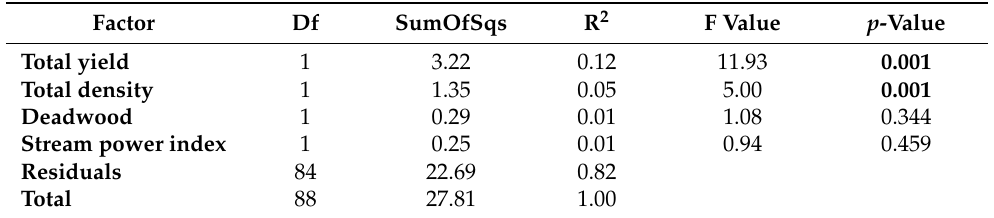
Table 1. ADONIS analysis—effects of total yield, total stand density, amount of deadwood and stream power index to understory species composition (including moss and plant species).